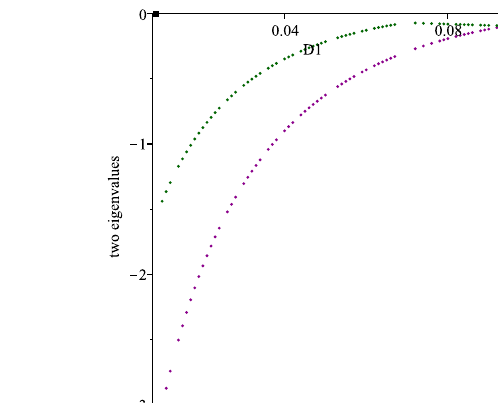
Figure 4. Eigenvalues of ∆ ( 3 ) evaluated at ( ¯ S su , ¯ S aa , ¯ X suaa ) for D 1 ∈ ( 0, D horizontal axis denotes D